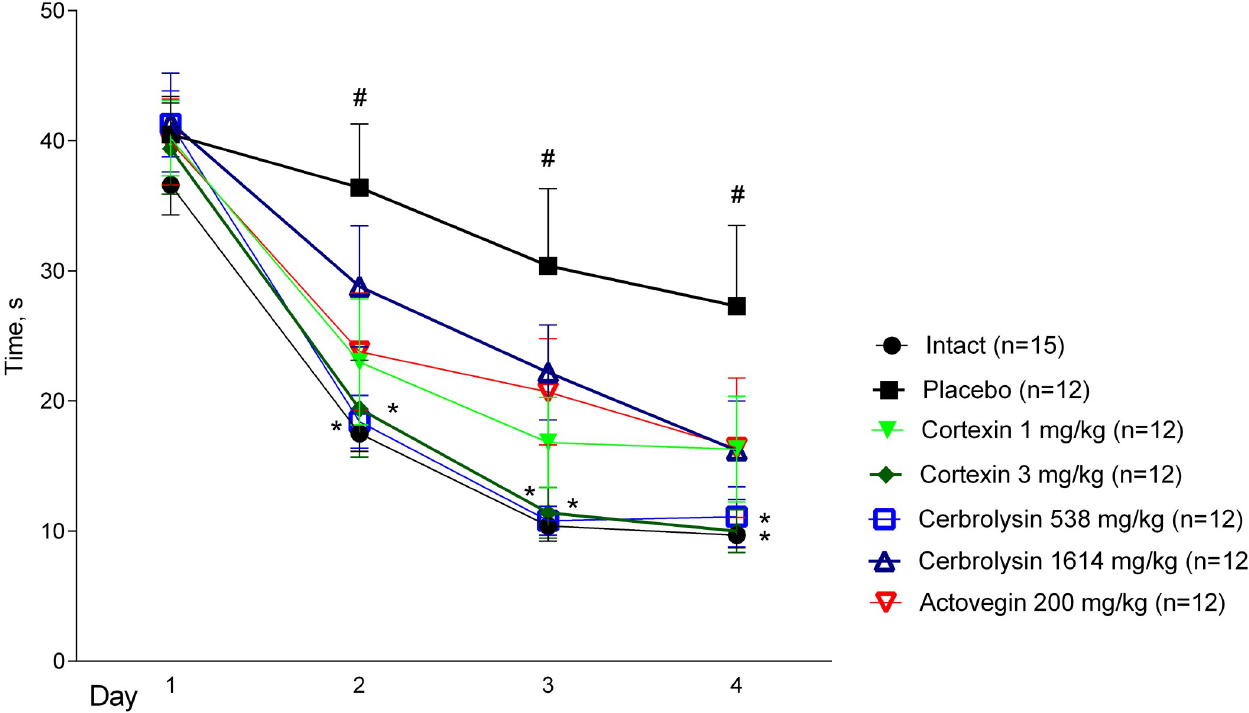
Fig 7. Morris water maze performance in rats during the course of therapy after left middle cerebral artery occlusion. #–p < 0.05 compared to Intact; � –p < 0.05 compared to placebo (Kruskal-Wallis rank analysis and the Dunn post-hoc test); data shown as the mean ± SEM.